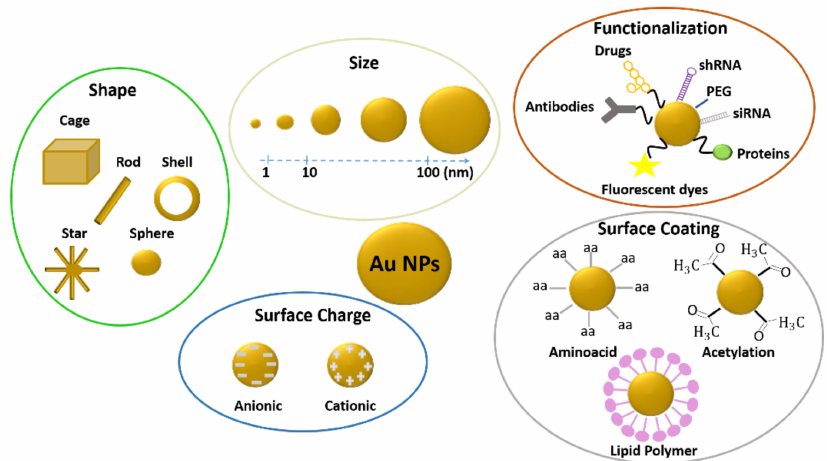
Figure 2. Different factors influencing the gold nanoparticles’ toxicity: shape, size, functionalization, surface charge, and surface coatings. Abbreviations: shRNA: Short hairpin RNA; PEG: Poly (Ethylene Glycol); siRNA: Short interfering